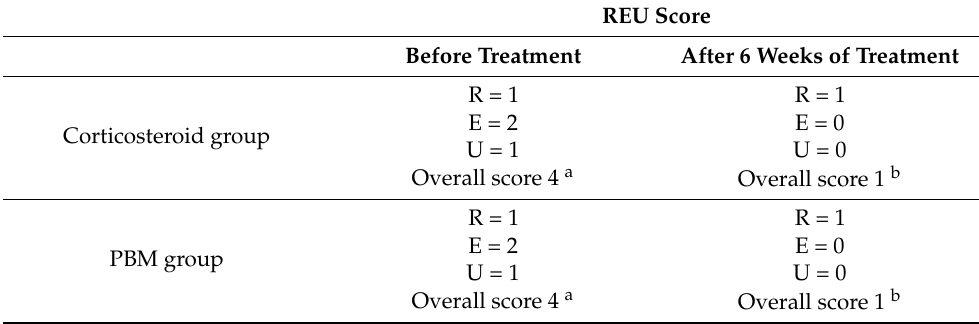
Table 4. Total values of the REU score for oral lichen planus before and at the end of treatment for each group. Similar letters indicate non-significant differences. Different letters indicate significant differences.